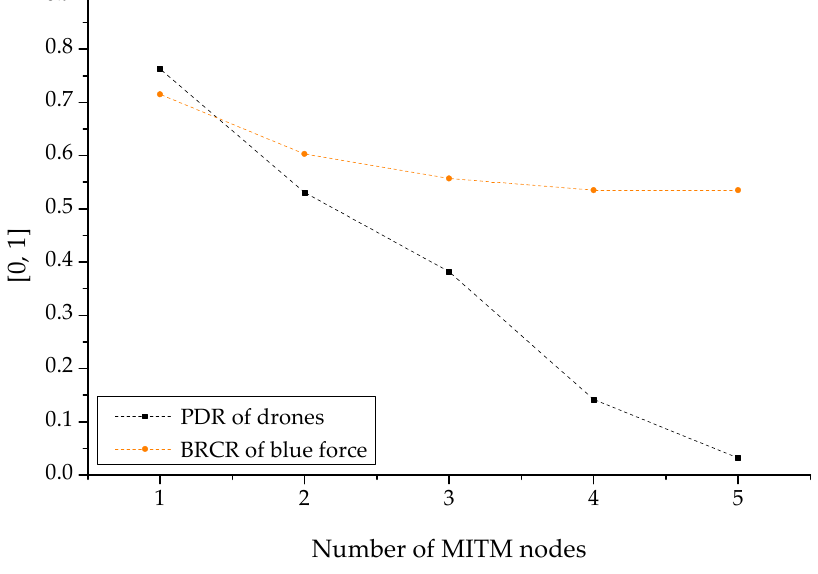
Figure 17. PDR (packet delivery ratio) and BRCR (blue remaining combat ratio)-based graph by MITM.